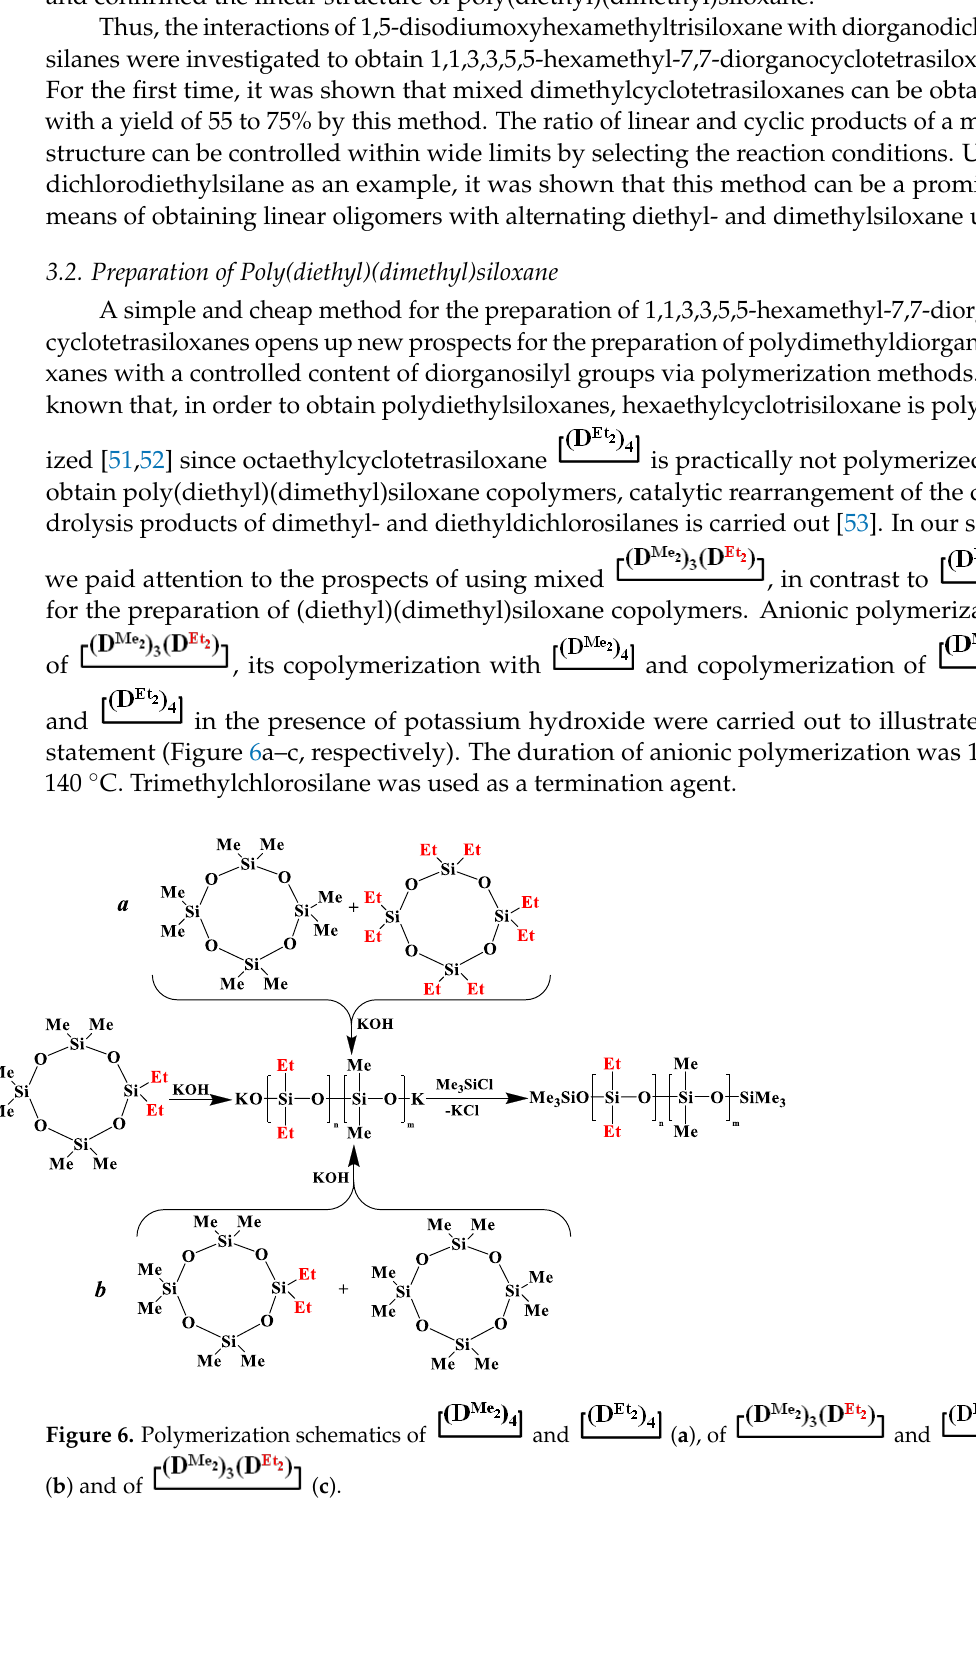
Figure 5. 1 H NMR spectrum and GPC curve of blocked linear poly(diethyl)(dimethyl)siloxane (№ 10, Table 2).